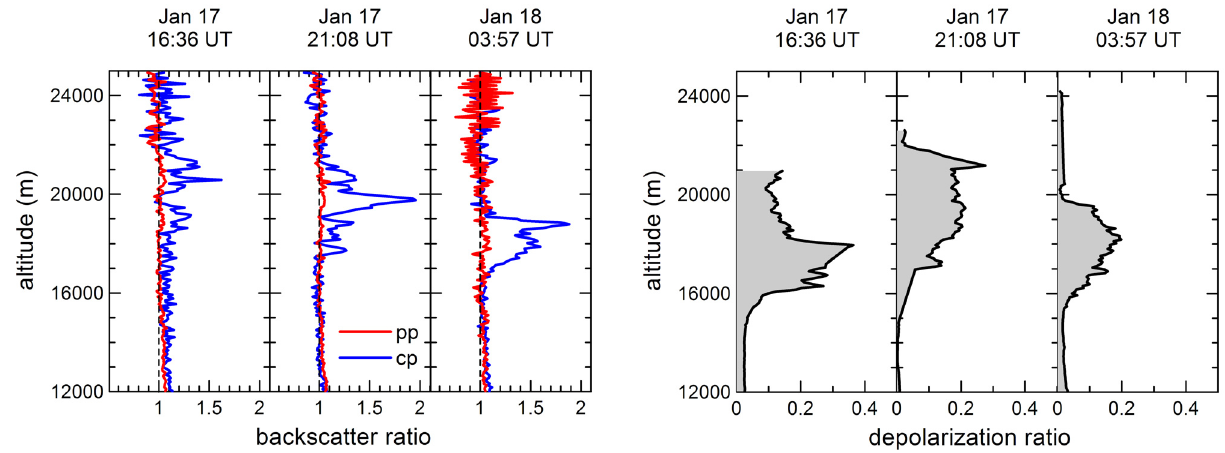
Figure 13. Lidar derived backscatter (left panel) and depolaritazion (right panel) ratioes between 12 and 25 km for the parallel and cross po- larized components of the signal acquired on January 17 at 16:36 UT and 21:08 UT , and on January 18 at 03:57 UT.